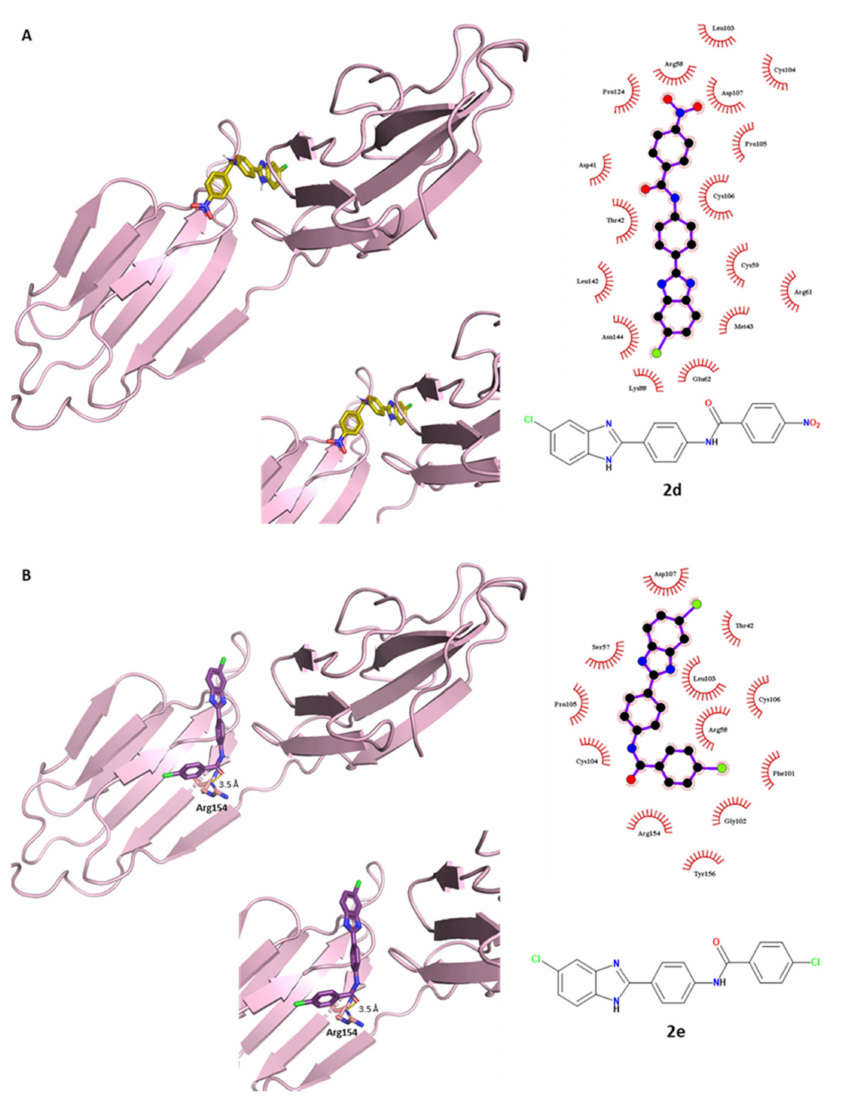
Figure 6. Electrostatic and hydrophobic contacts between E2 protein and compounds ( A ) 2d and ( B ) 2e , colored in gold and purple,